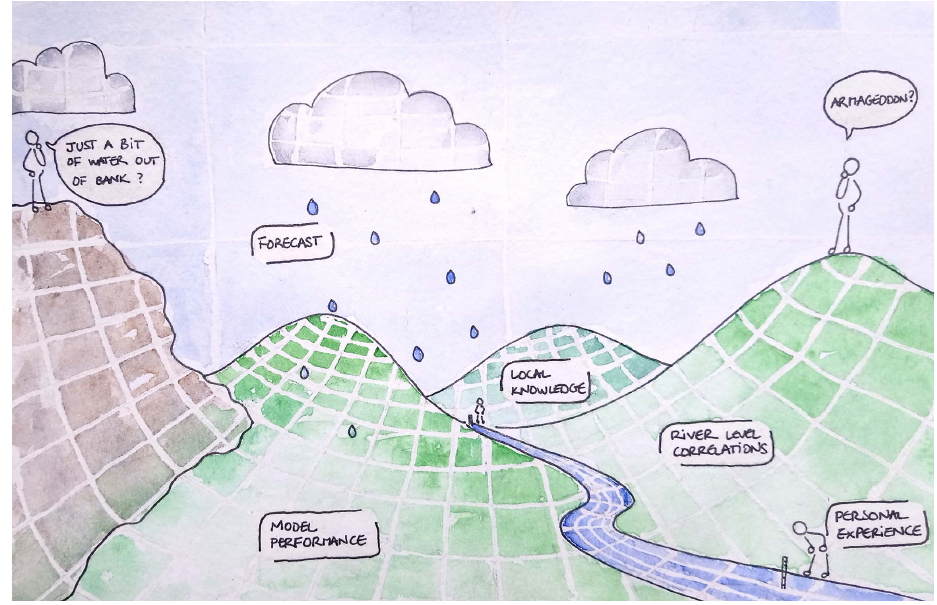
Figure 3. Complex flood forecast interpretation landscape in which EA Duty Officers